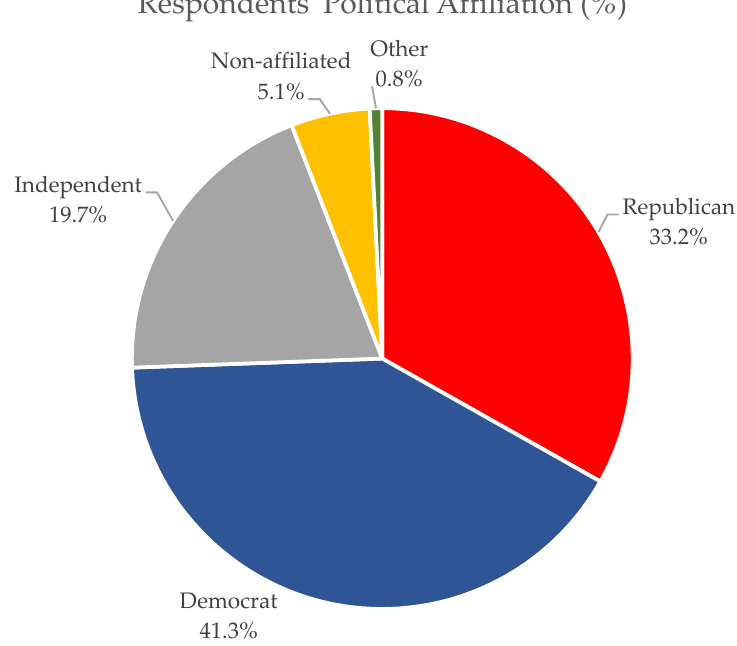
Figure 3. Respondents’ self-reported political affiliation (N = 1049).